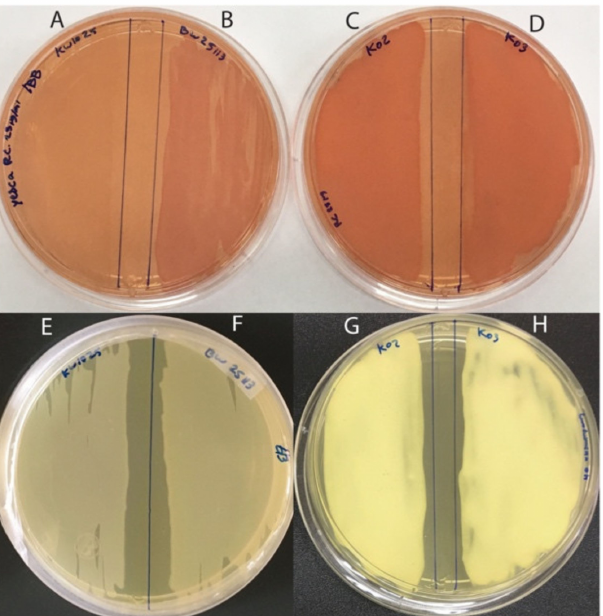
Figure 4. Detection of β -amyloid protein curli in kefir beverages. Presence of curli in kefir beverages K02 ( C , G ) and K03 ( D , H ) evaluated on YESCA agar supplemented with Congo red (25 µ g/mL) and Coumassie-Brilliant Blue G-250 at (1 µ g/mL) ( A – D ) and YESCA agar supplemented with curcumin (18 µ g/mL) ( E – H ). Escherichia coli strain KW1025 ( ∆ csgA ::Km) was used as negative control ( A , E )